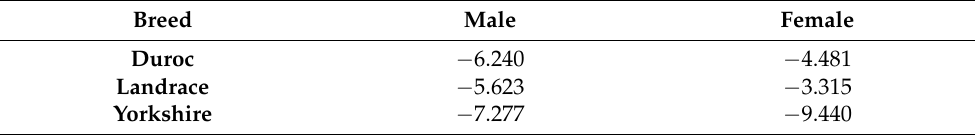
Table A2. Constant correction coefficients for BF of pig